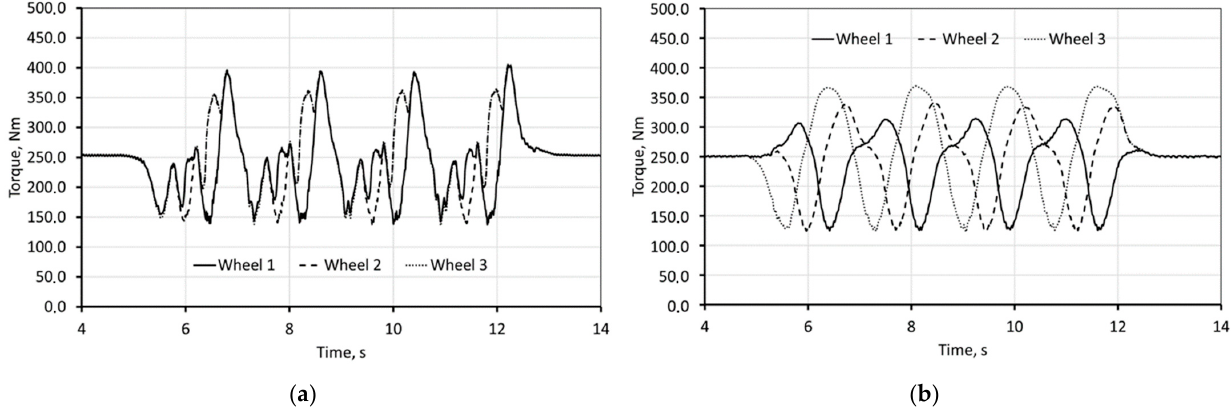
Figure 16. Torque on wheels with nominal pump flow for spool flow divider ( a ) and gear-type flow divider ( b ).